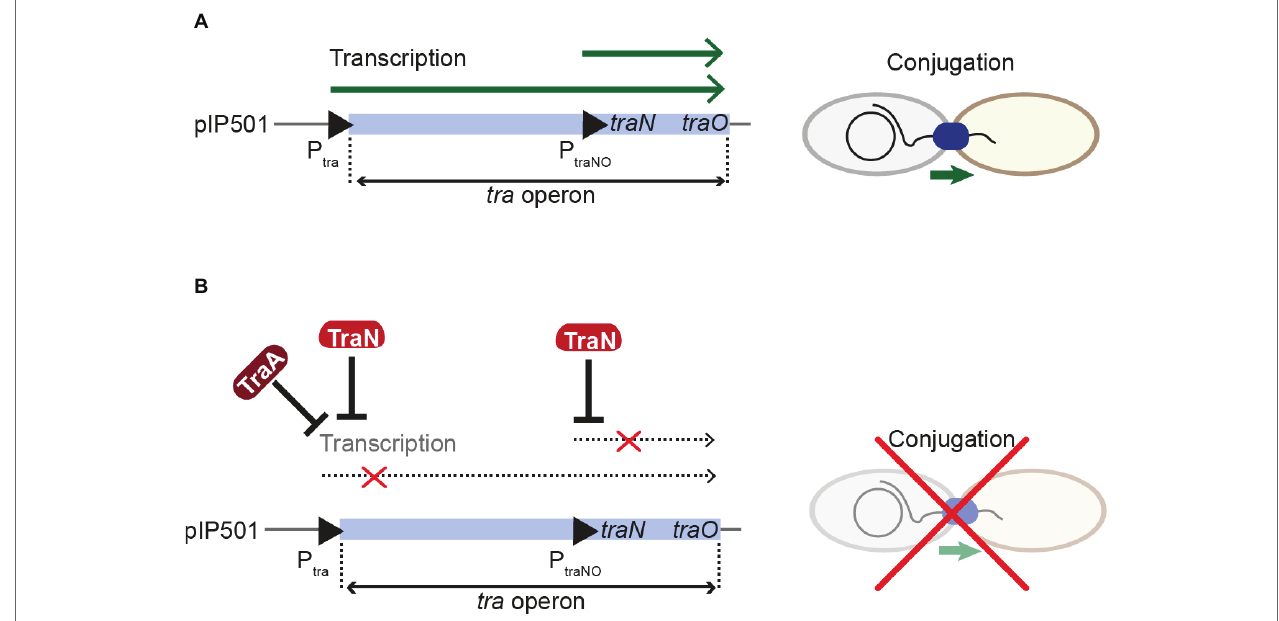
FIGURE 7 | Regulation of pIP501 conjugative transfer. (A) Transcription of the pIP501 transfer genes is executed by two promoters, P tra and P traNO , leading to the production of factors required for conjugative transfer. (B) By a concerted action between the relaxase TraA and TraN, transcription from the P tra promoter is reduced. Further, TraN can repress the P traNO promoter upstream of its own gene. These regulative processes lead to inhibition of conjugative